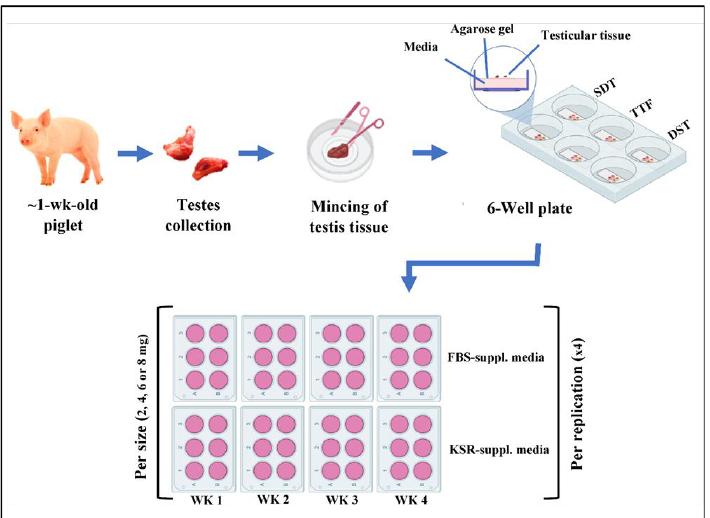
Figure 1. Schematic representation of the experimental design. Testes from neonatal donor piglets were divided into testicular fragments of four different sizes, underwent one of the three tissue preparation methods, and were cultured in either of the two differently supplemented media. Two fragments from each group were placed on an agarose gel cube soaked in the designated media, and samples were taken weekly for 4 weeks. PDF = physically dispersed fragments, IF = intact fragments, SDF = semi-digested fragments. FBS-suppl. = DMEM + 10% FBS culture media. KSR-suppl. = DMEM + 10% KSR culture media.